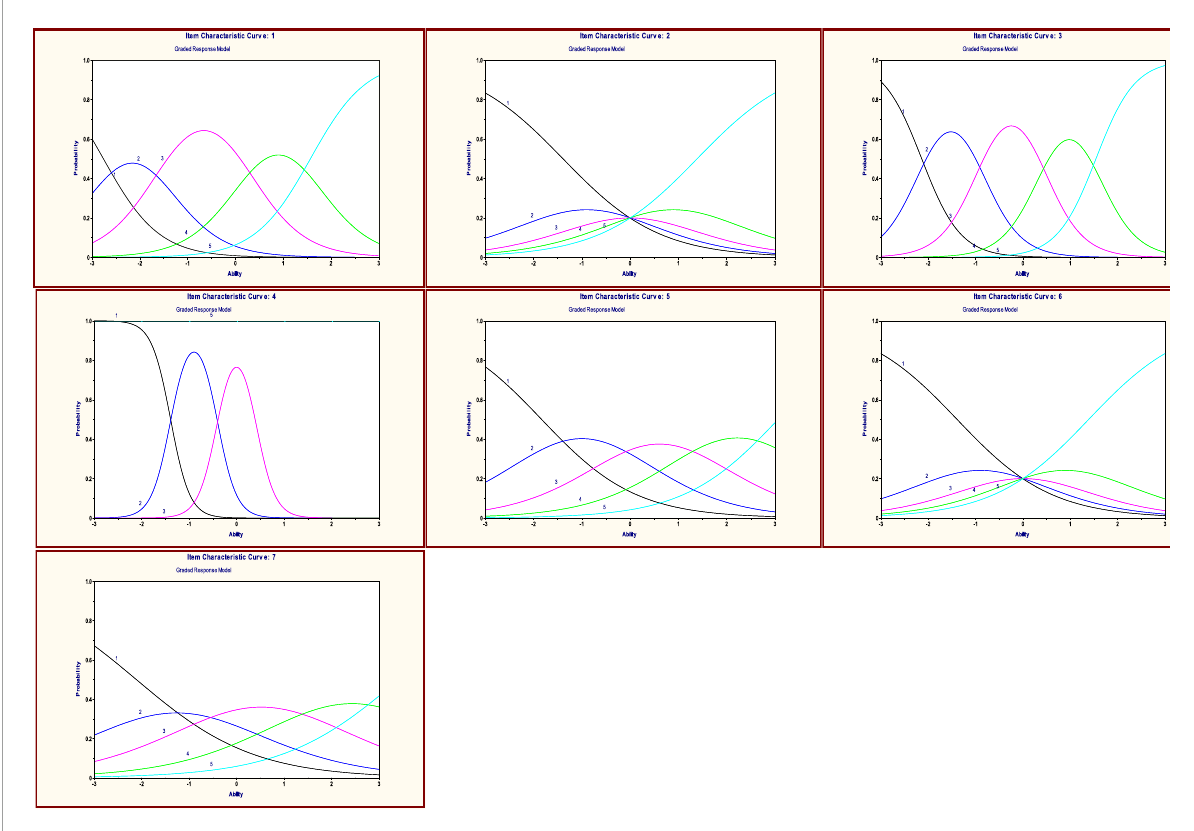
FIGURE2 Item Characteristic Curves of the seven items of the IOS – Grade Response Model. Category response curves for the seven items of the IOS. From left to right in the first column (item 1, item 2, item 3); From left to right in the second column (item 4, item 5, item 6); in the third column (item